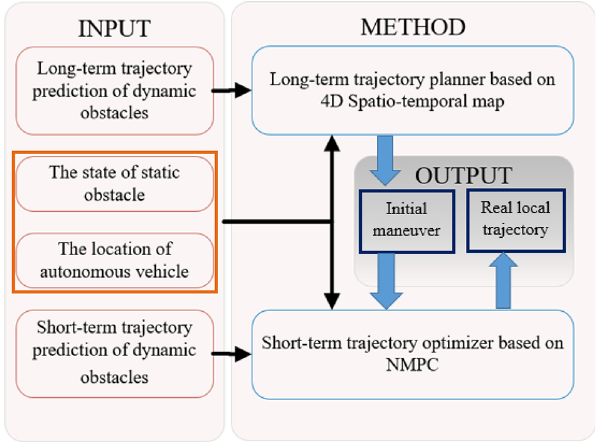
Figure 1 Framework of long- and short-term mixed trajectory